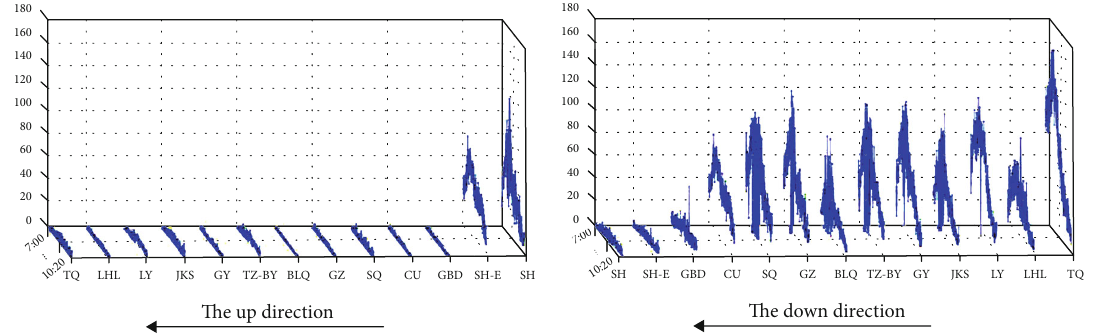
Figure 6: The arrival passenger volume on the up and down direction of the Batong line. Table 4: Comparison of the total passenger waiting time with NPC and WPC ( L = 1